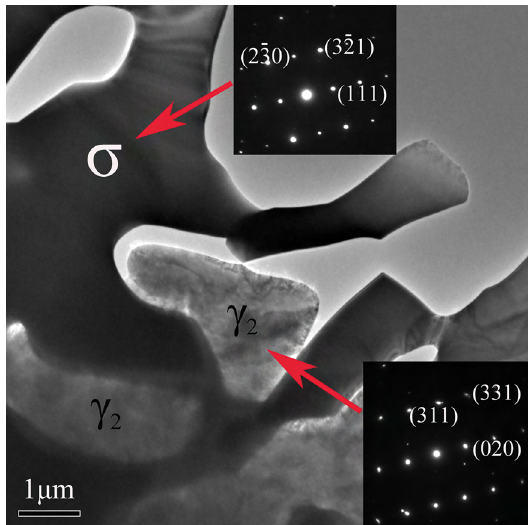
Figure 6. TEM micrograph of the Z3CN20.09M specimen aged at 750 °C for 200 h.